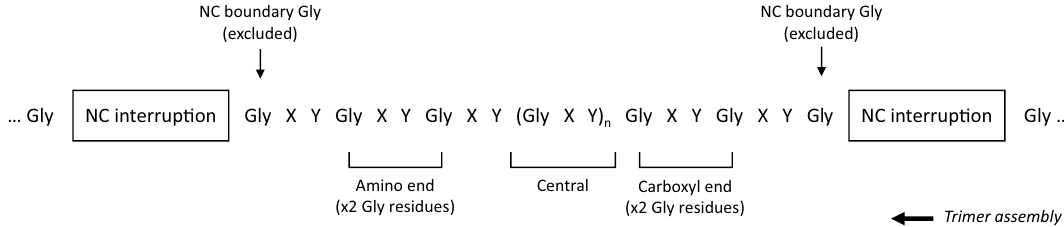
Figure 1. Terminology used in this study to describe the position of Gly residues with respect to their local collagenous region. One single ‘local’ collagenous region is shown, bounded by non-collagenous interruptions at either end. The boxes could also represent either of the two non-collagenous termini. The non-collagenous boundary Gly residues are a special case, so were not included in this subgroup. The larger arrow indicates the direction of trimerisation, which is initiated at the carboxyl terminus and then proceeds in the amino direction. NC,